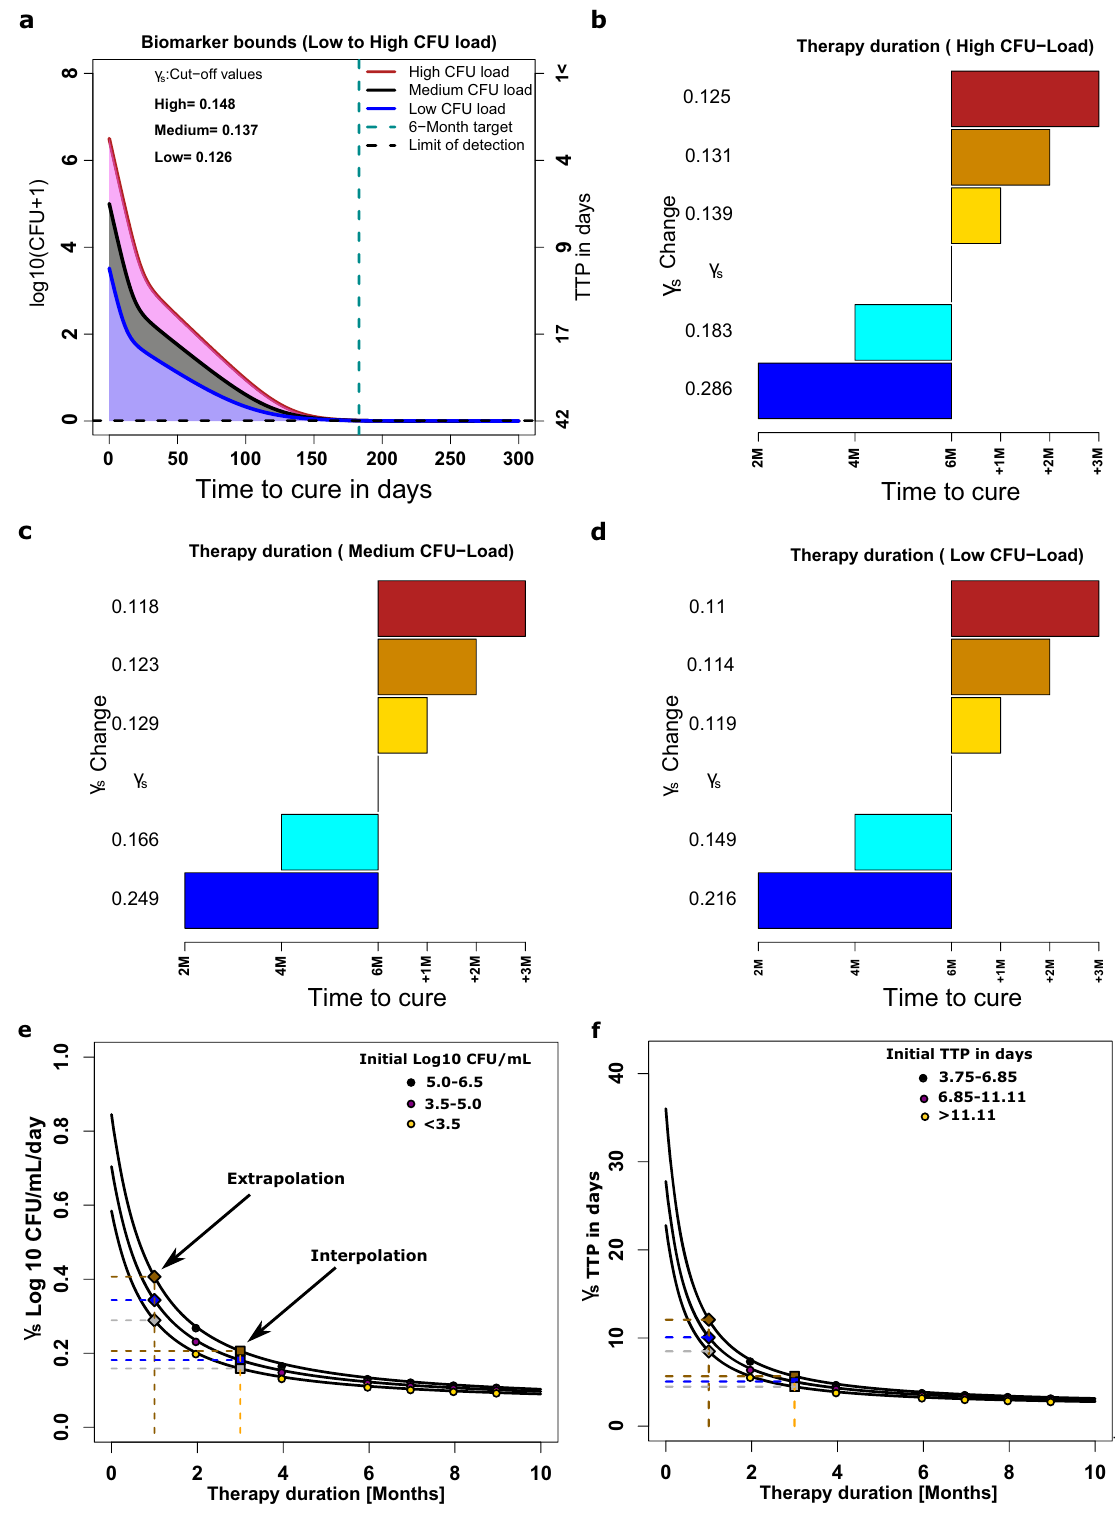
negative. The RR of failure with the rule was 8.25 (95%